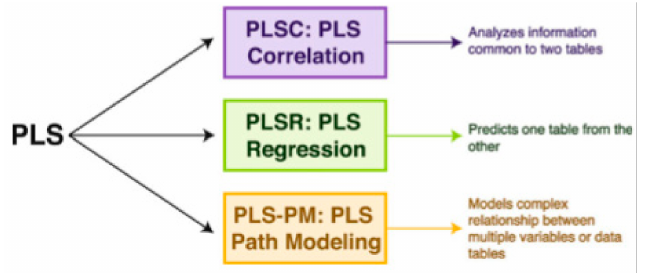
Figure 4. PLS methods with their main goals. PLS Correlation is the method adopted in this